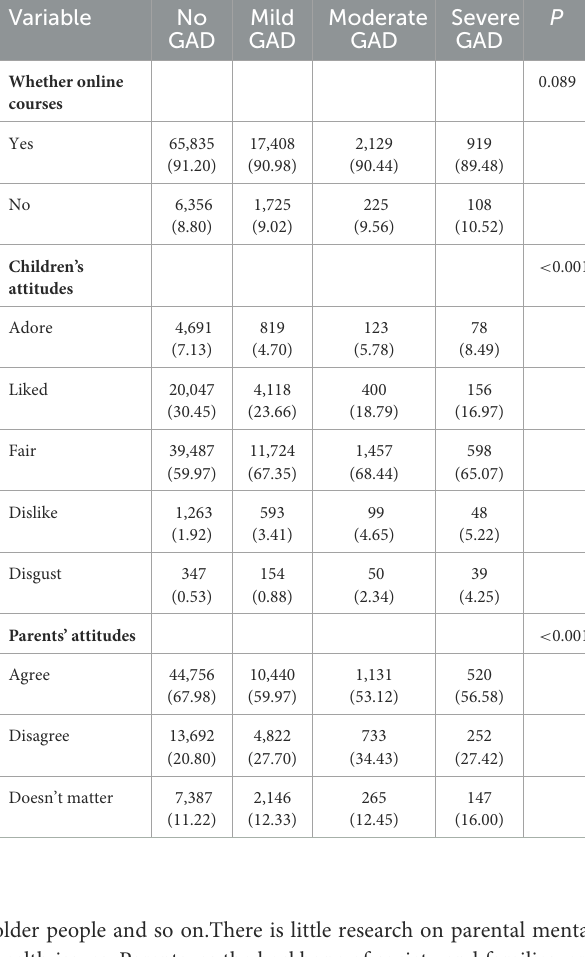
TABLE 2 The influence of family members and their own COVID-19 infection on anxiety.